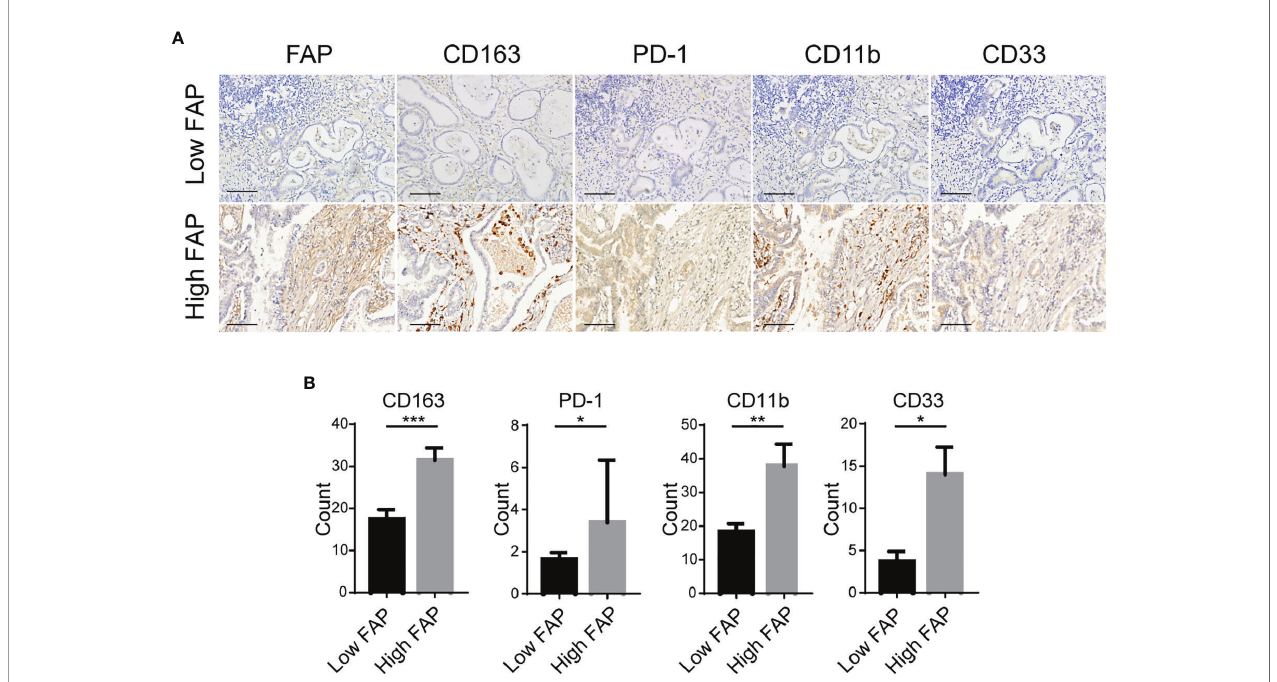
FIGURE 3 | Association between the expression of FAP and immunosuppressive TME. (A) Representative images of IHC staining of FAP, macrophage M2 (CD163+), MDSC (CD11b+/CD33+) in fi ltration, and PD-1 expression in GC tissue microarrays. Scale bar = 100 µm. (B) Quantitative results of IHC for CD163, CD11b, CD33, and PD-1 in groups with low intensity and high intensity of FAP in GC tissue microarrays. * p < 0.05; ** p < 0.01; *** p < 0.001.